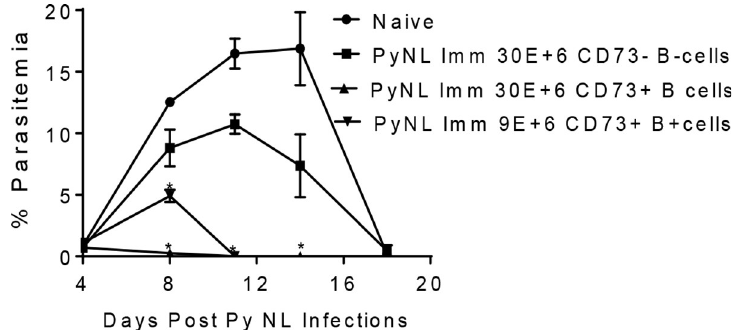
nonimmune, naive mice. Two hours after the transfer of cells, mice were infected i.p. with 1 x 10 6 PyNL erythrocytic stage parasites. Parasitemias were evaluated by blood smears starting at day 4 post-infection until